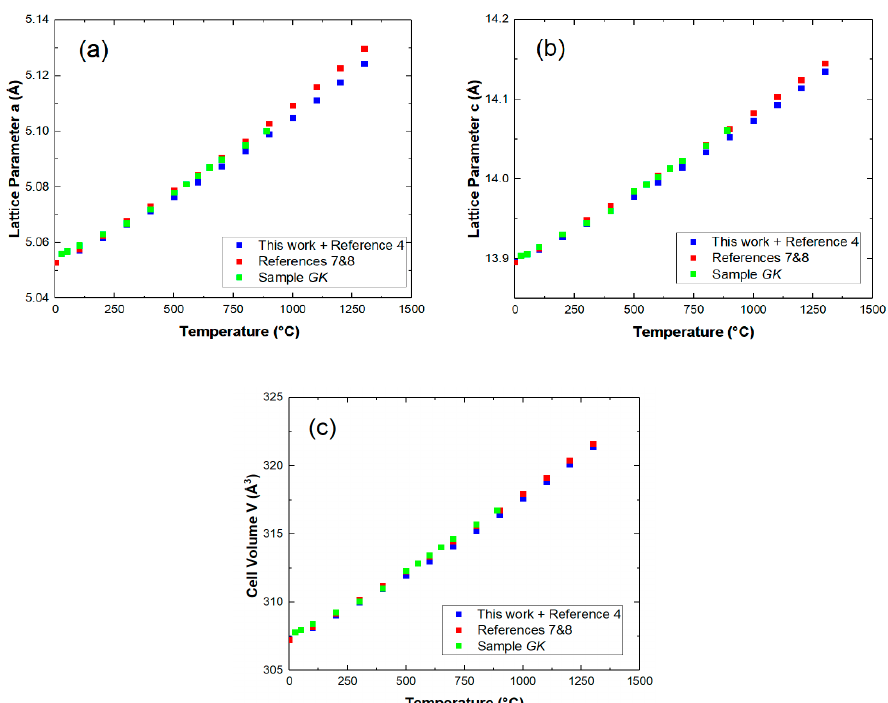
Figure 5. ( a ) Calculated lattice parameter a of MgTiO 3 versus temperature, derived from Equations (13) and (14) and experimental lattice parameter a of geikielite from sample GK. ( b ) Calculated lattice parameter c of MgTiO 3 versus temperature, derived from Equations (13) and (14) and experimental lattice parameter c of geikielite from sample GK. ( c ) Calculated lattice volume of MgTiO 3 versus temperature, derived from Equations (13) and (14) and experimental lattice volume of geikielite from sample GK.